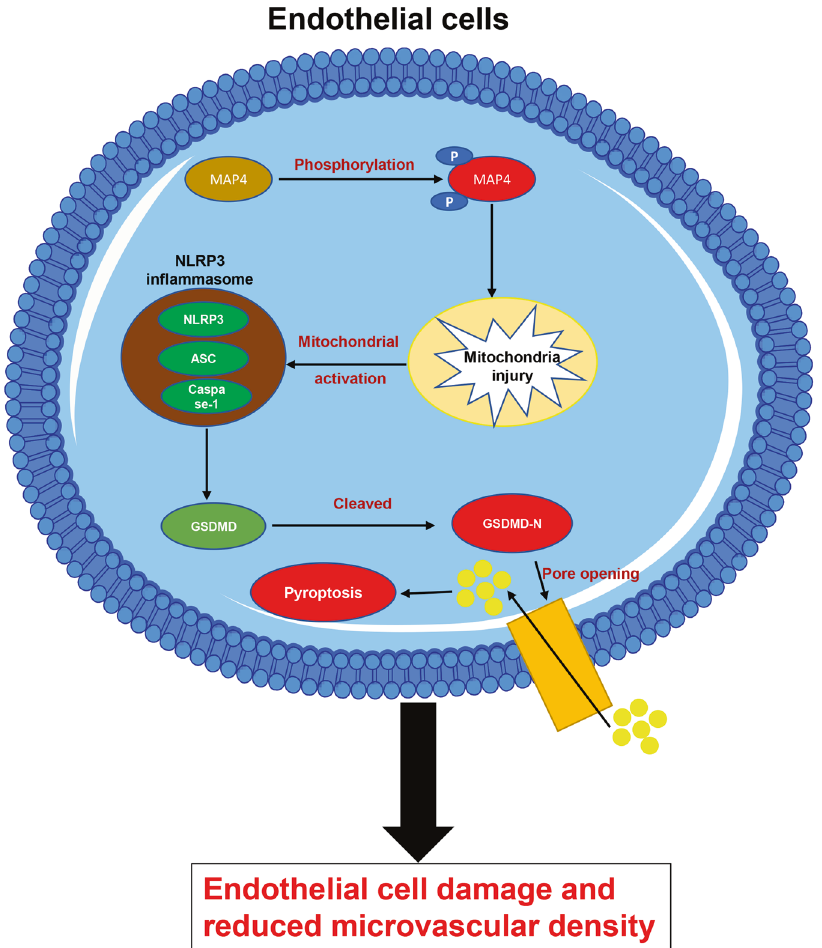
Fig. 6 Schematic illustrating the reduction of cardiac microvascular intensity by the phosphorylation of MAP4. The phosphorylated MAP4 activates the NLRP3 in fl ammasome, further triggering pyroptosis in endothelial cells. This results in angiogenic disorder and reduced cardiac microvascular